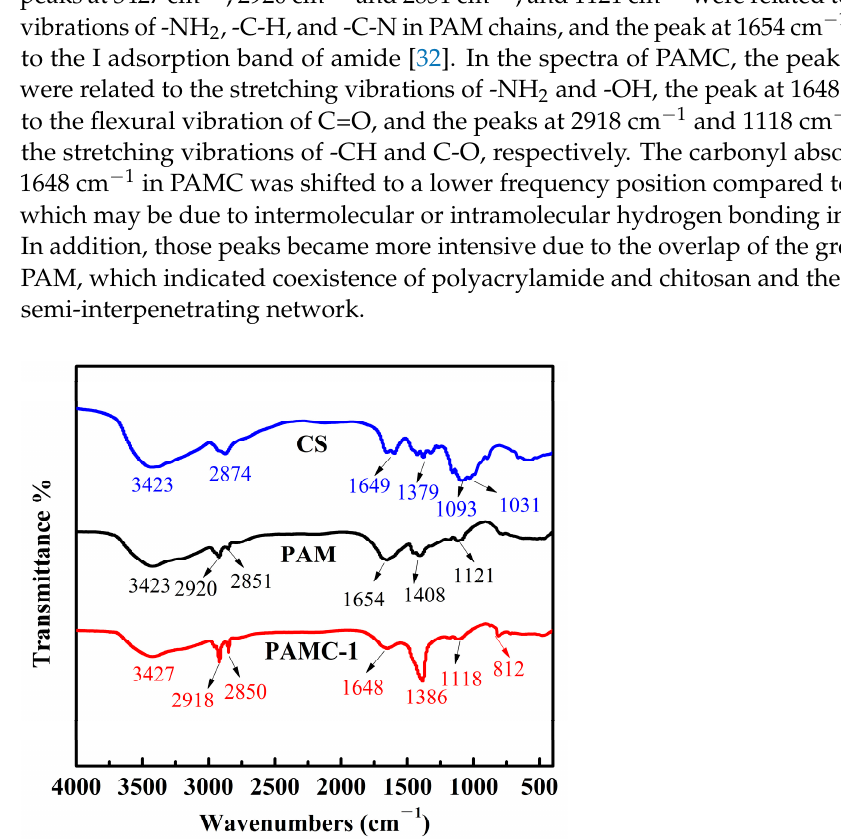
Figure 3. SEM image of hydrogels: ( a ) PAMC; ( b ) the partial enlarged detail of ( a ). 3.2. Adsorption in Solution 3.2.1. Adsorption in Different Concentrations of NaCl Solution The adsorption capacity of the PAMC gel in different concentrations of sodium chlo- ride solution was studied. The adsorption isotherm equation was fitted according to the experimental data, and the adsorption mechanism of PAMC on chloride ions was clari- fied. As useful mathematical tools, adsorption isotherms can describe the adsorption type and intensity between adsorbent and adsorbate as well as show the adsorption level be- tween the solid phase and the ion with different concentrations of solution. The Langmuir isotherm in the liquid phase usually represents the solute adsorbed as a single molecular layer on the adsorption site on the surface of the adsorbent with the equation shown in Equation (4):